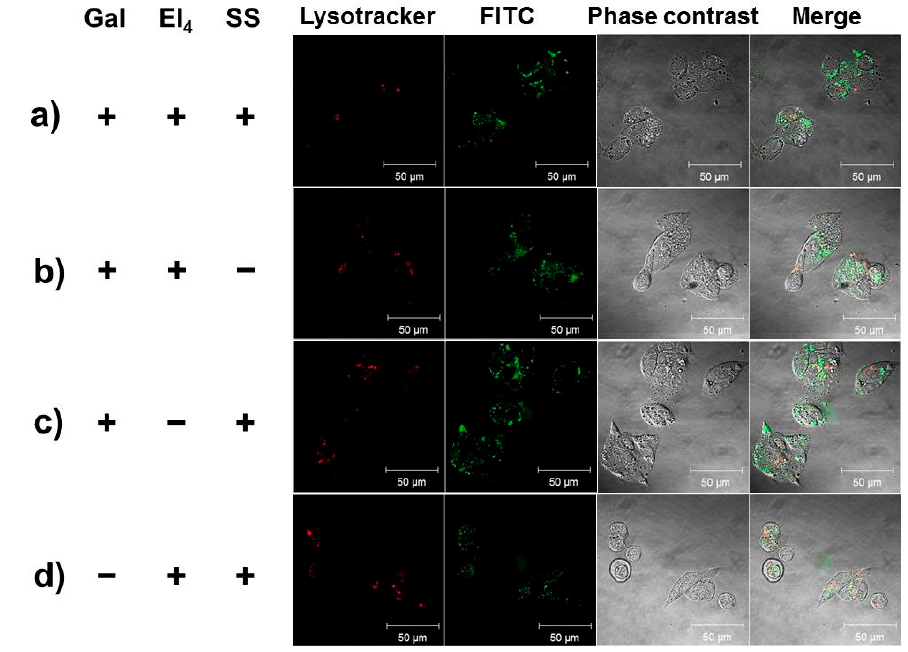
Figure 7. Confocal laser scanning microscopy (CLSM) images of HepG2 cells with various FITC-labeled nanogels and LysoTracker RED after 5 min incubation at 37 °C. ( a ) EI 4 /Gal-Dex- g -SS-OLA, ( b ) EI 4 /Gal-Dex- g -OLA, ( c ) Gal-Dex- g -SS-OLA, and ( d ) EI 4 -Dex- g -SS-OLA. Scale bar: 50 µm.